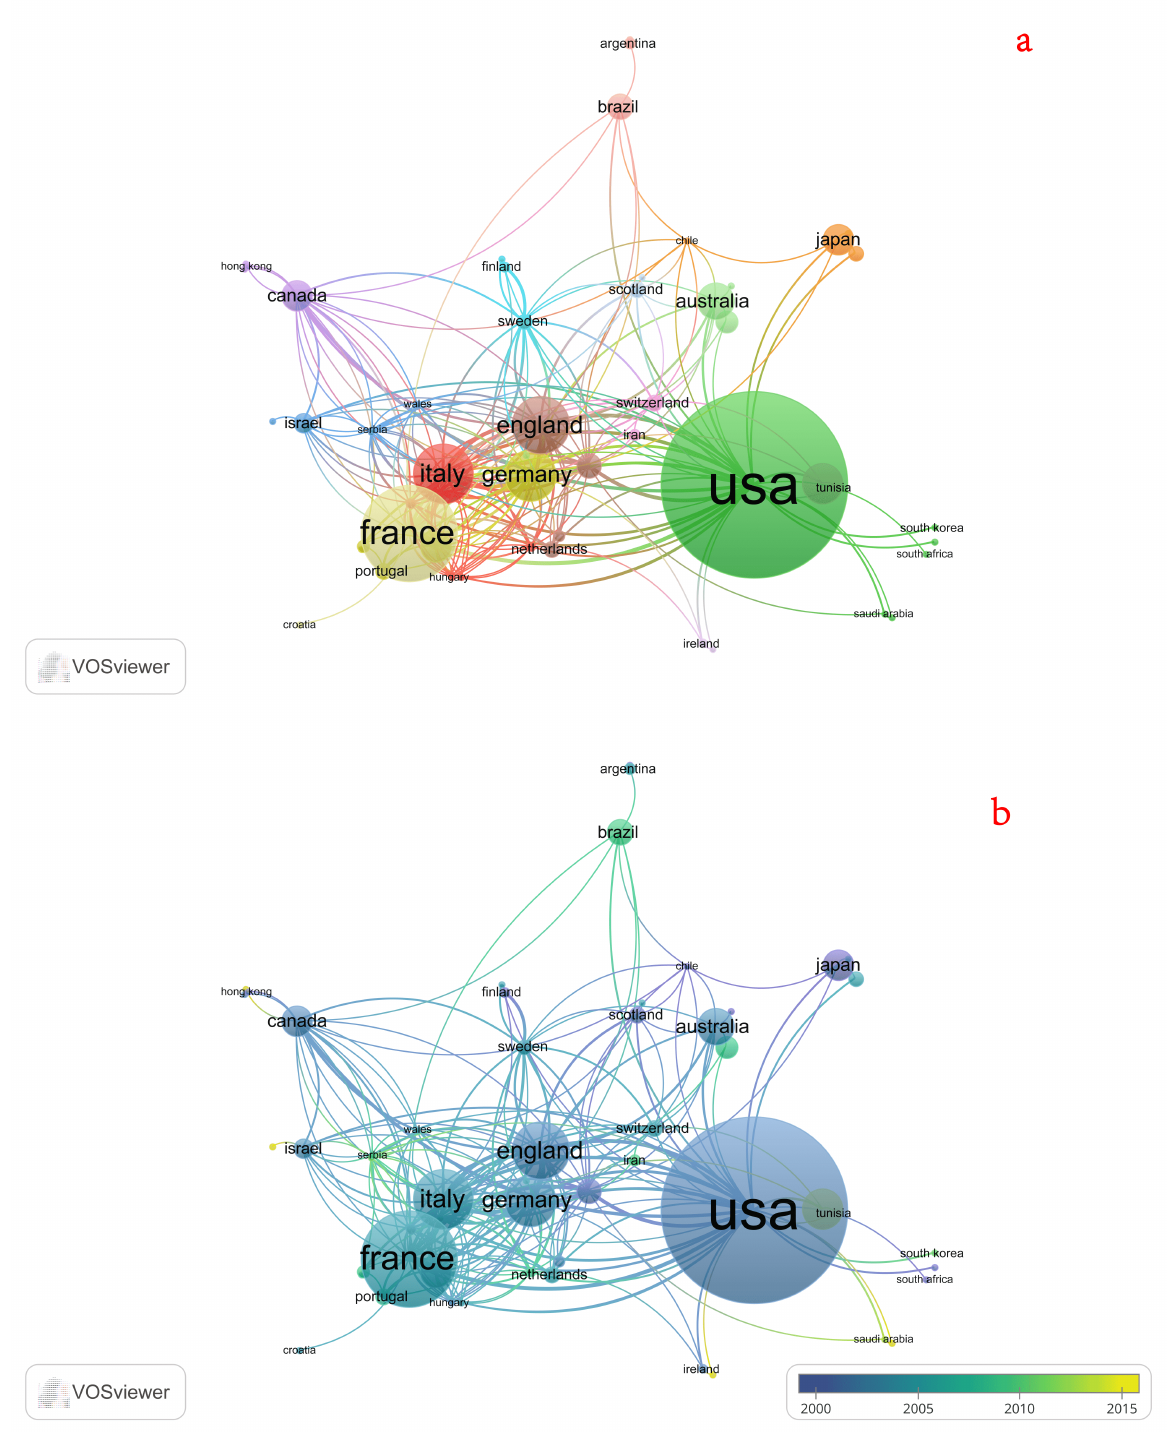
Fig. 3. The font size of each country/region’s name represents the number of articles in the country/region. The thickness of the curved connecting line represents the collaborative intensity between countries/regions. (a) The country collaboration network of AVD research. (b) Different colors inside the circle represent different time